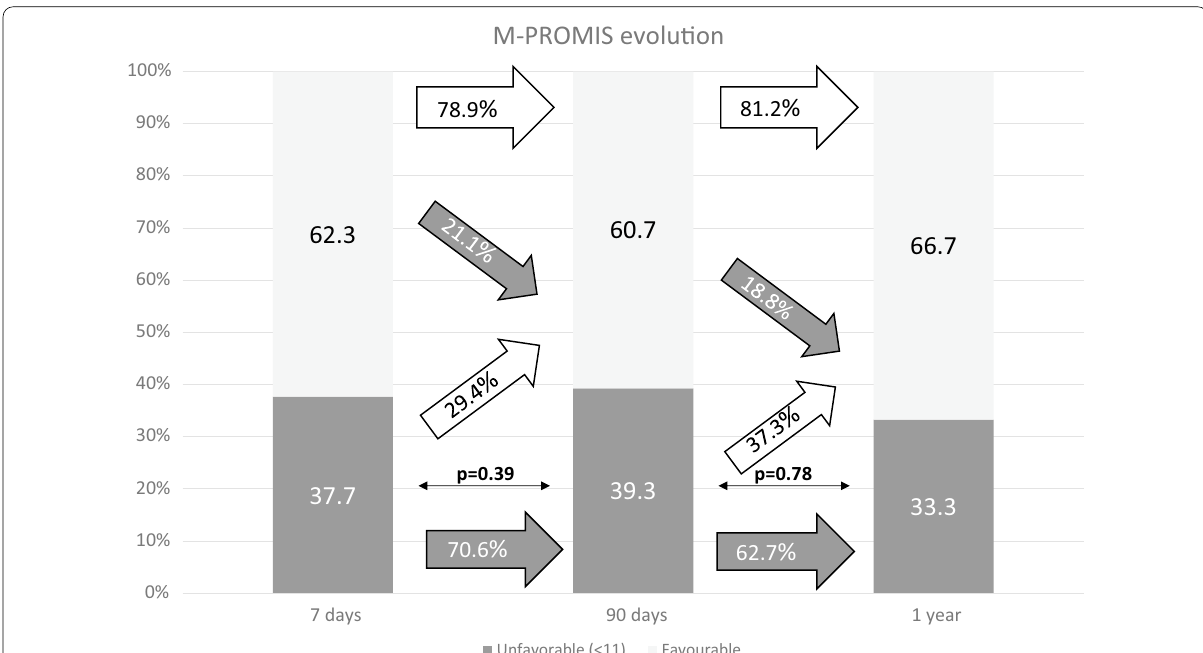
Fig. 3 Rate of favorable and unfavorable results in the mental sub‑score of PROMIS‑10 scale (M‑PROMIS) at different time‑points along follow‑up: 7 days, 90 days and one year after stroke. The white arrows represent the rate of patients with improvement in the measured PROM or persistence of favorable outcome at the following time‑point of evaluation. The gray arrows represent impairment toward an unfavorable result in the measured PROM or unfavorable outcome persistence. Thin arrows represent statistical comparison of the rate of favorable/unfavorable outcomes as compared with the previous time‑point. *Statistically